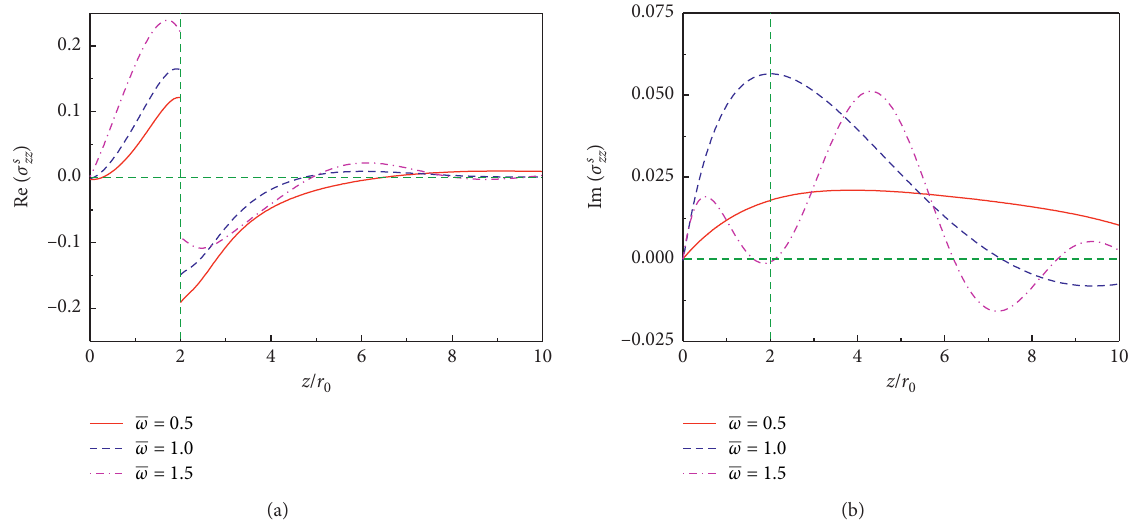
Figure 5: Vertical stress σ s zz induced by unit vertical load on π s : (a) real part of vertical stress; (b) imaginary part of vertical stress.